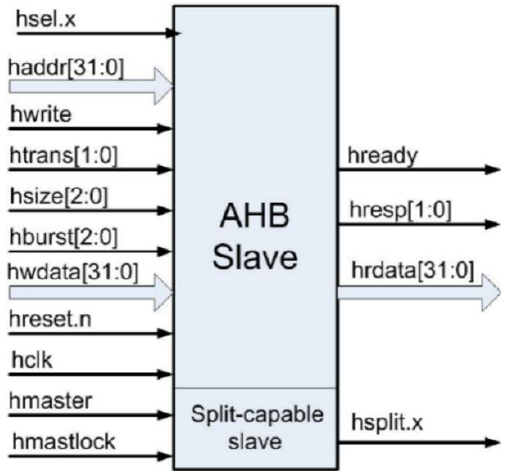
Fig. 5. AHB bus slave interface